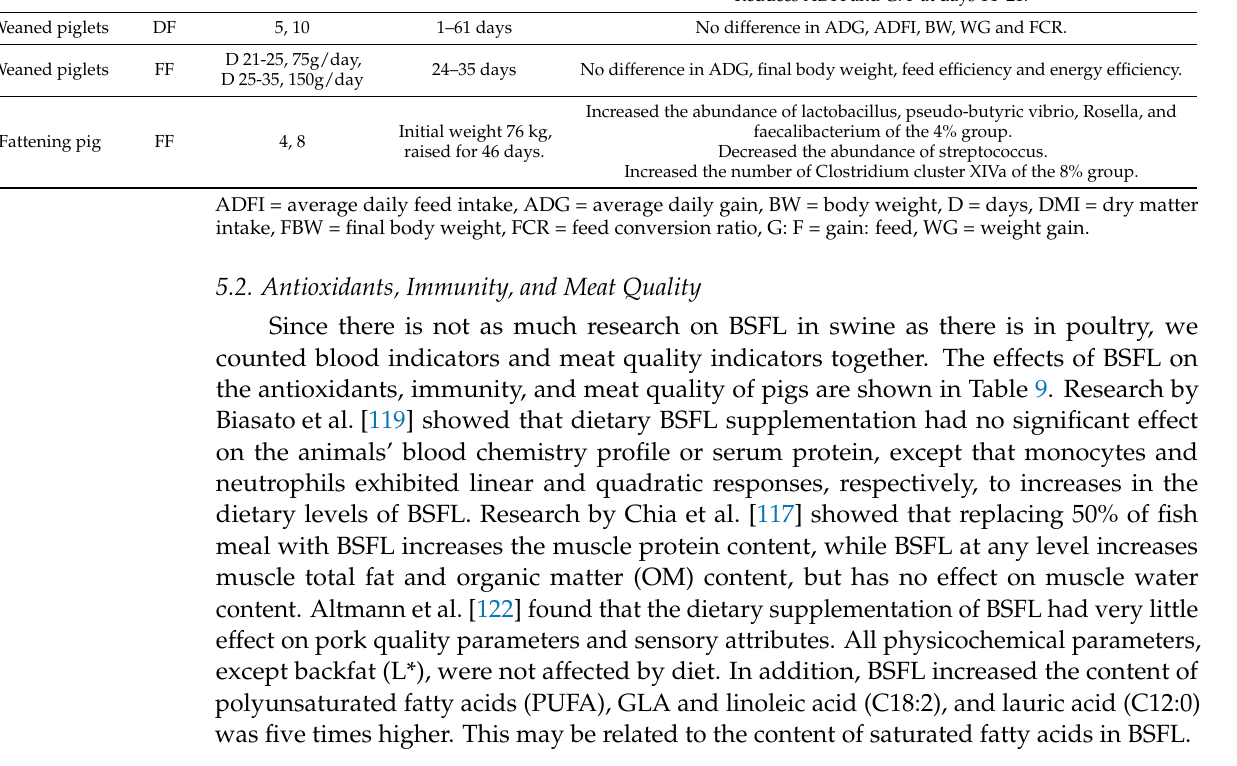
Table 9. Effects of BSFL on the antioxidant, immunity, and meat quality of